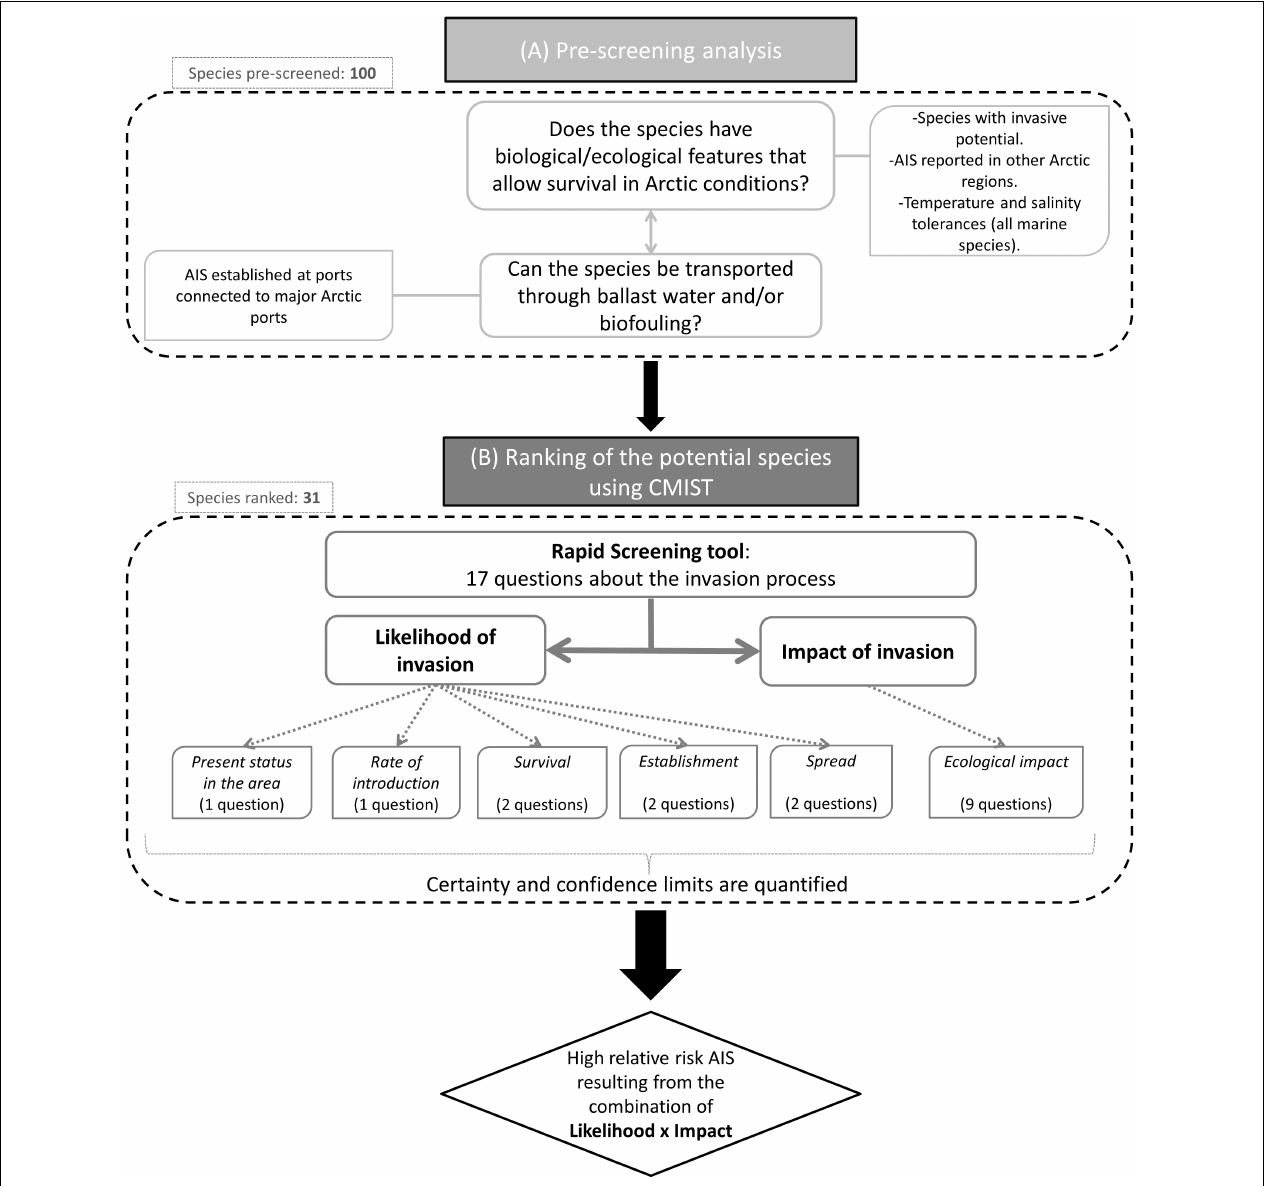
FIGURE 2 | Overview of the species selection ( Panel A: Pre-screening analysis) and assessment process using the CMISt tool ( Panel B: Ranking of